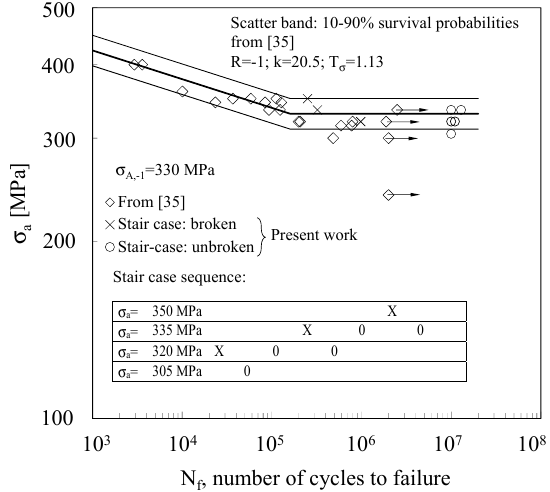
Figure 9. Push-pull, stress-life curve of AISI 304L cold-drawn bars.